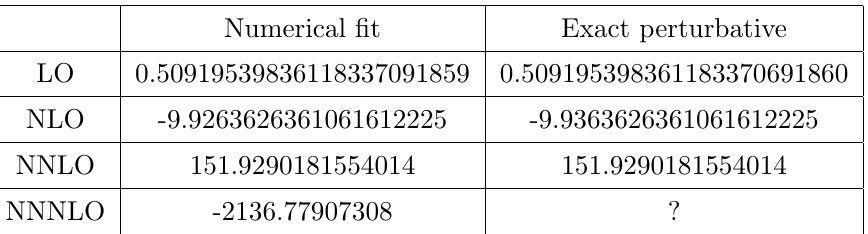
Figure 4 . Dependence of S on the coupling constant for (cid:1) = 0 : 45 and n = 1. Red dots depict the numerical result and dashed line depicts the sum of analytical perturbative results at LO and NLO orders.